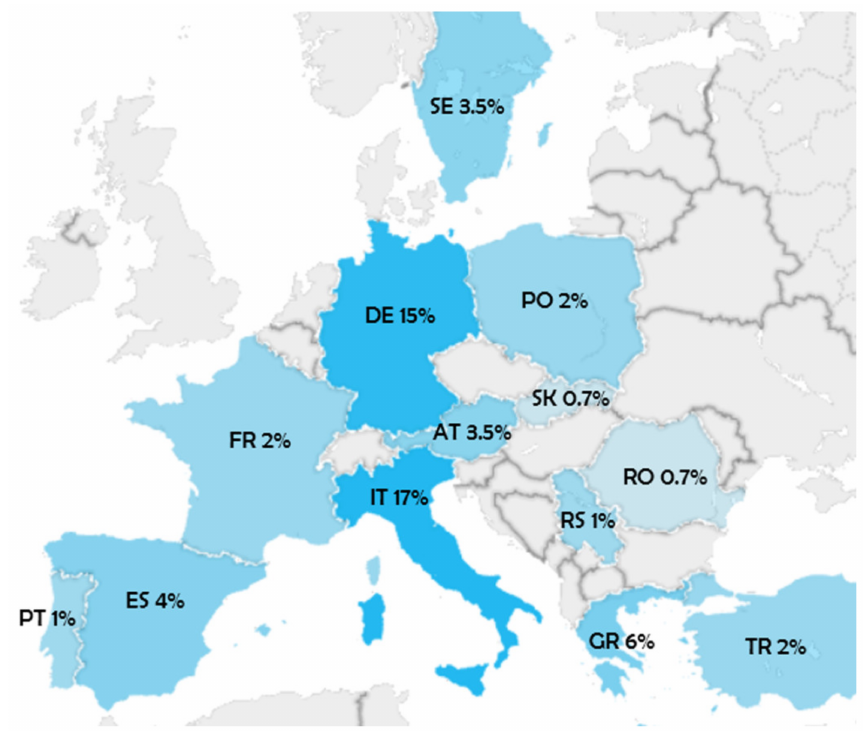
Figure 4. European countries from which relevant publications come.